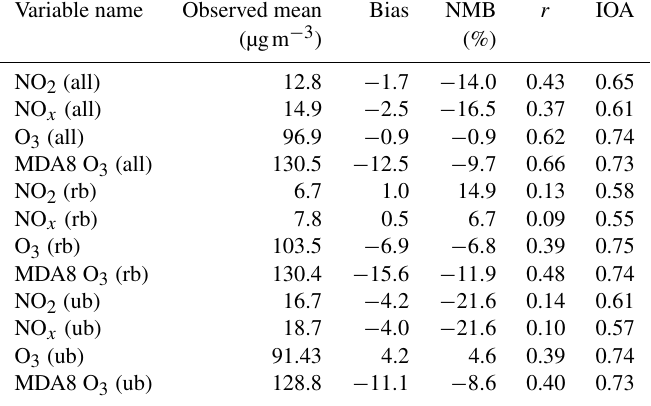
Table 5. Observed mean and simulation summary statistics for NO 2 , NO x , O 3 , and MDA8 O 3 concentrations. The bias, normalized mean bias (NMB), correlation coefficient ( r ), and index of agreement (IOA) are calculated between simulated and observed concentrations at the German background (all), urban and suburban backgrounds (ub), and rural (rb) stations during the 1–8 August 2018